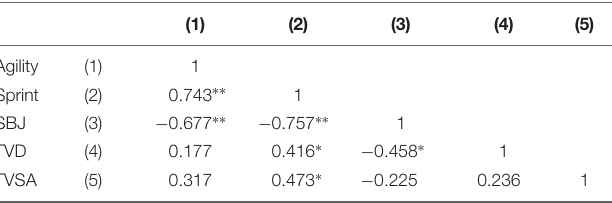
TABLE 4 | Relationship between performance variables in Football Group.